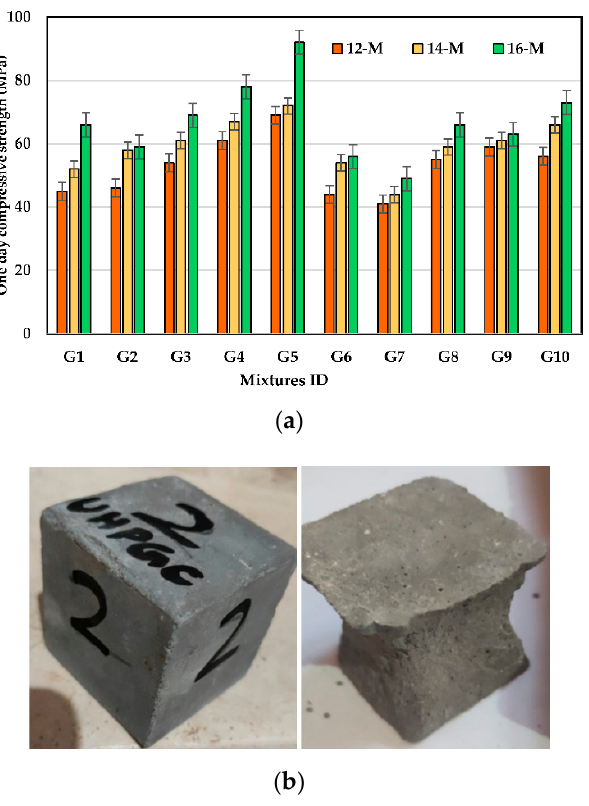
Figure 7. The performance of UHPGC at early ages. ( a ) Effect of KOH molarity and ASM type on 24 h CS at curing heat 60 ◦ C; ( b ) UHPGC before and after testing at 24